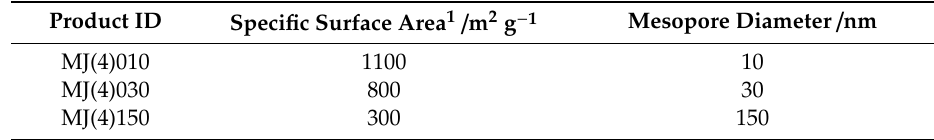
Table 1. Information on the mesoporous carbons used in this